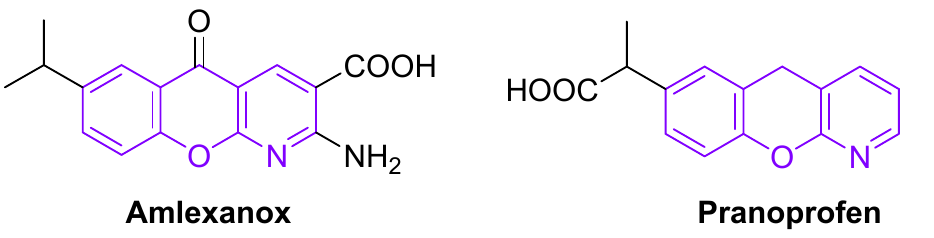
Figure 1. Some biologically active chromeno[2,3- b